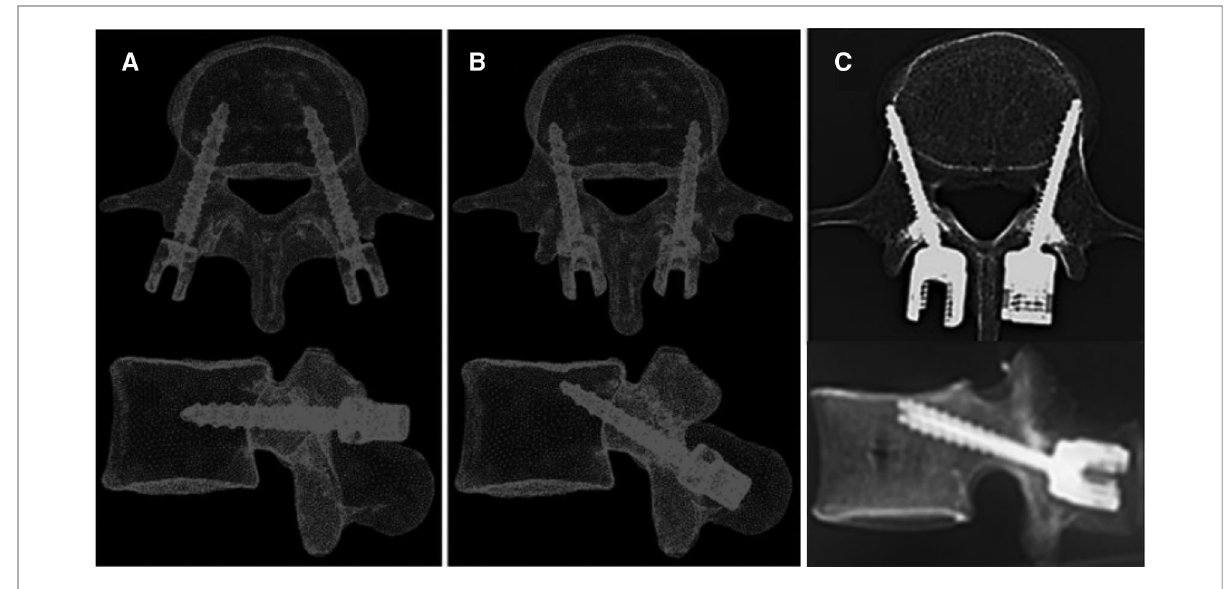
FIGURE 1 Schematic diagram of three different lumbar posterior fi xations: ( A ). traditional trajectory (TT) (9), ( B ) cortical bone trajectory (CBT) (9), and ( C ) modi fi ed cortical bone trajectory (MCBT)